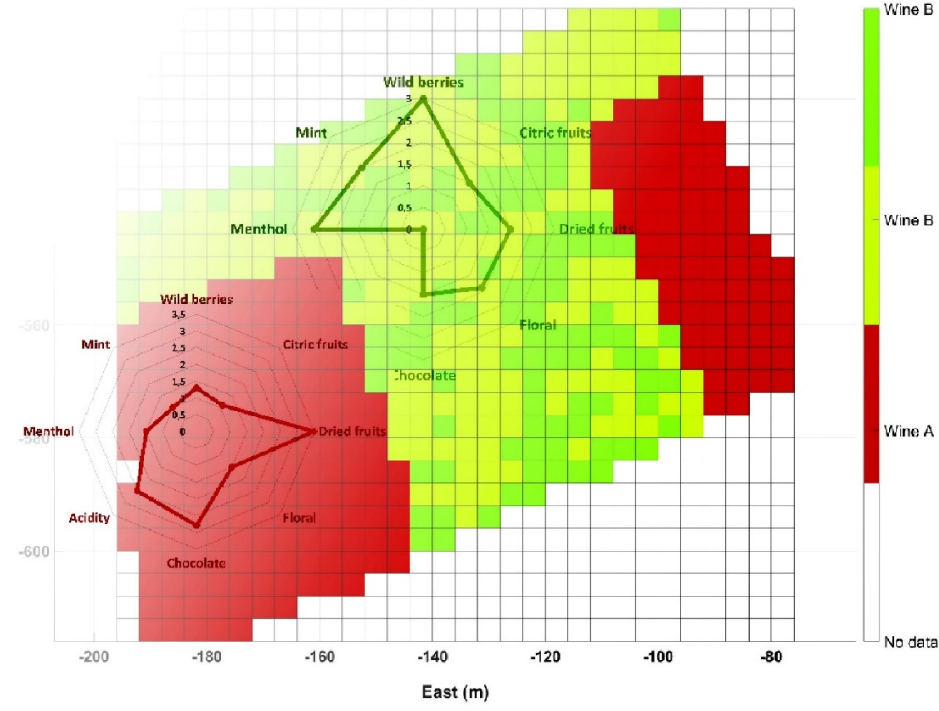
Figure 18. Differential harvesting recommendation map.